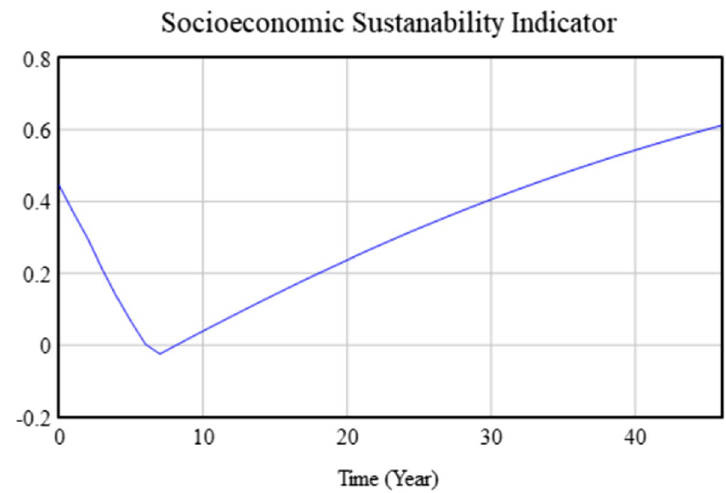
Fig. 11 The dynamic socioeconomic sustainability indicator results for the I-4 Ultimate